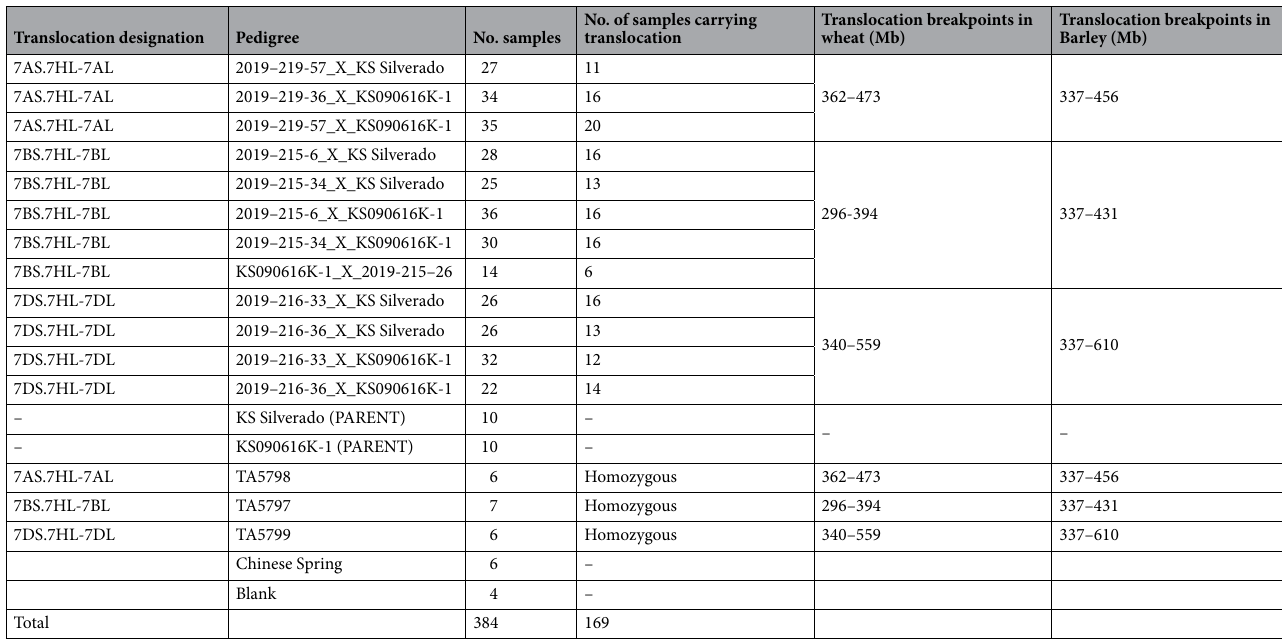
Table 2. Wheat-barley group 7 recombinants pedigree, number of samples in different groups, and translocation position